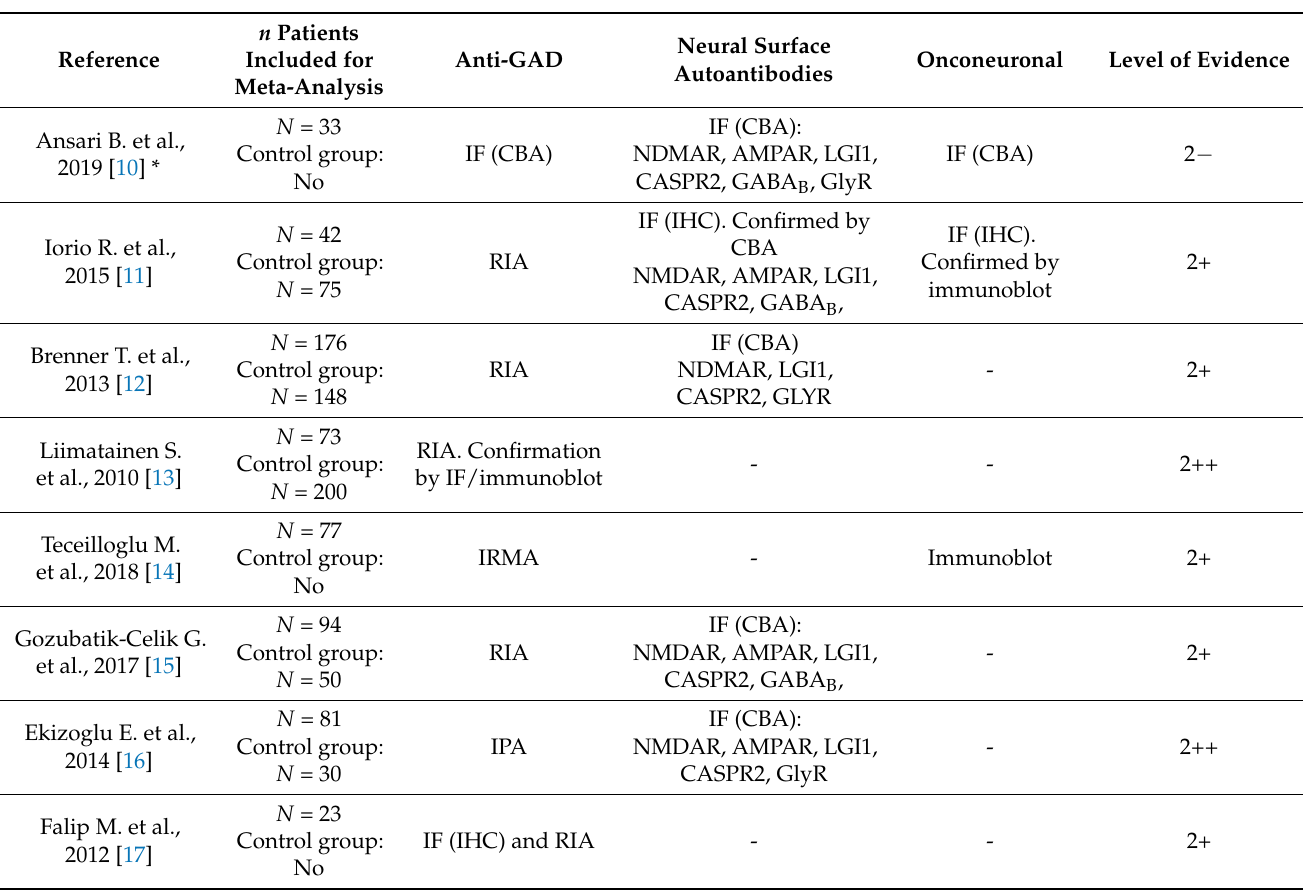
Table 1. Number of patients and antibody determination method of the included studies. AMPAR: amino-3-hydroxy-5- methyl-4-isoxazolepropionic acid receptor; CASPR2: contactin-2-associated protein; CBA: cell-based assay; GAD: glutamic acid decarboxylase; GlyR: glycine receptor; IHC: Immunohistochemistry; IRMA: immunoradiometric assay; LGI1: leucine- rich glioma inactivated-1 protein; NMDAR: N -methyl- D -aspartate receptor; RIA: radioimmunoassay. * not included in the